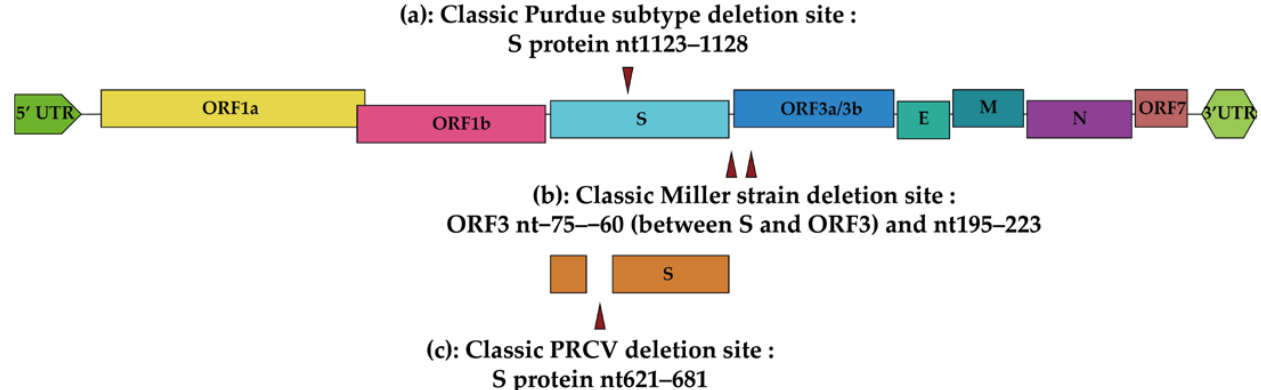
Figure 1. Schematic diagram of the TGEV genome structure. Non-structural proteins, including ORF1a and 1b, ORF3a/3b and ORF7; structural proteins, including spike (S), envelope (E), mem- brane (M), and nucleocapsid (N) proteins. S protein is used to divide different TGEV subtypes: ( a ) nt1123–1128 deletion of the S protein is considered to be Purdue strain; ( b ) ORF3 nt−75 – −60 and nt195–223 deletions (between S protein and ORF 3) are considered to be Miller subtypes; ( c ) and TGEV with a deletion of nt621–681 in S protein is variant strain PRCV and infects the porcine respiratory tract.